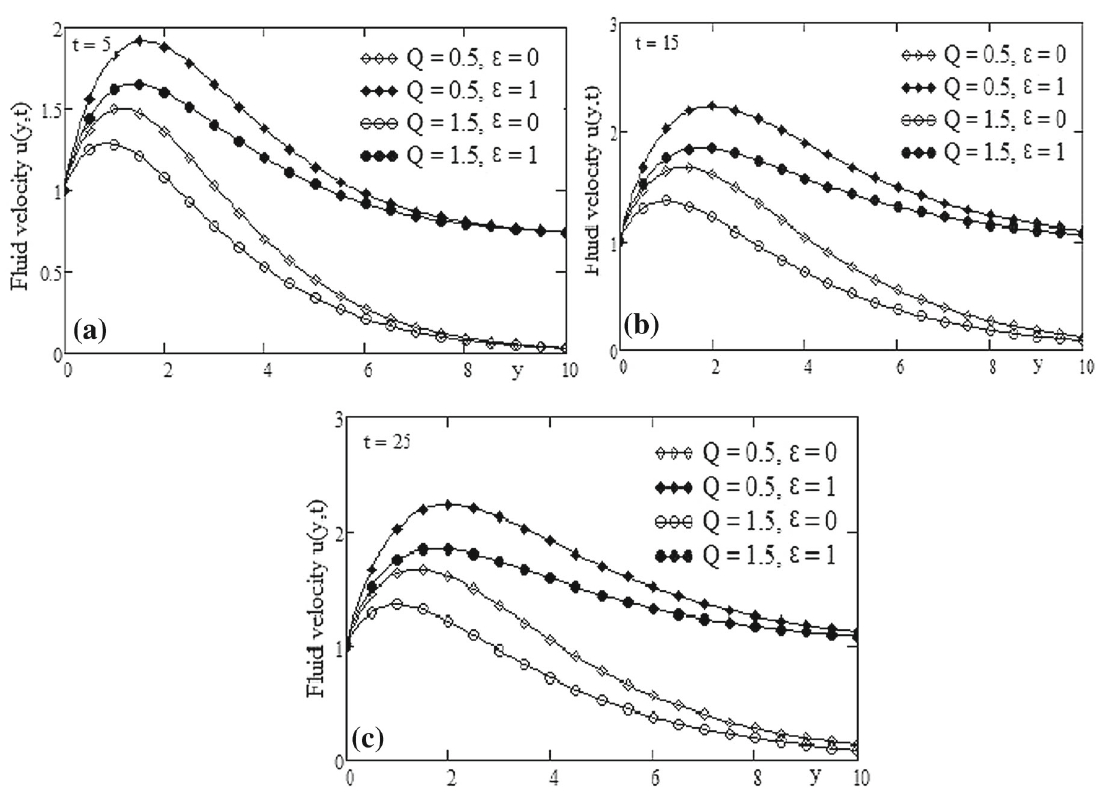
Fig. 5 Profiles of the dimensionless velocity given by Eq. (25) for Pr = 0 . 71, M = 0 . 25, Sc = 0 . 2, R = 0 . 7, Gr = 1 . 25, Gm = 0 . 5, Q = 0 . 5 and 1.5 and different values of time t